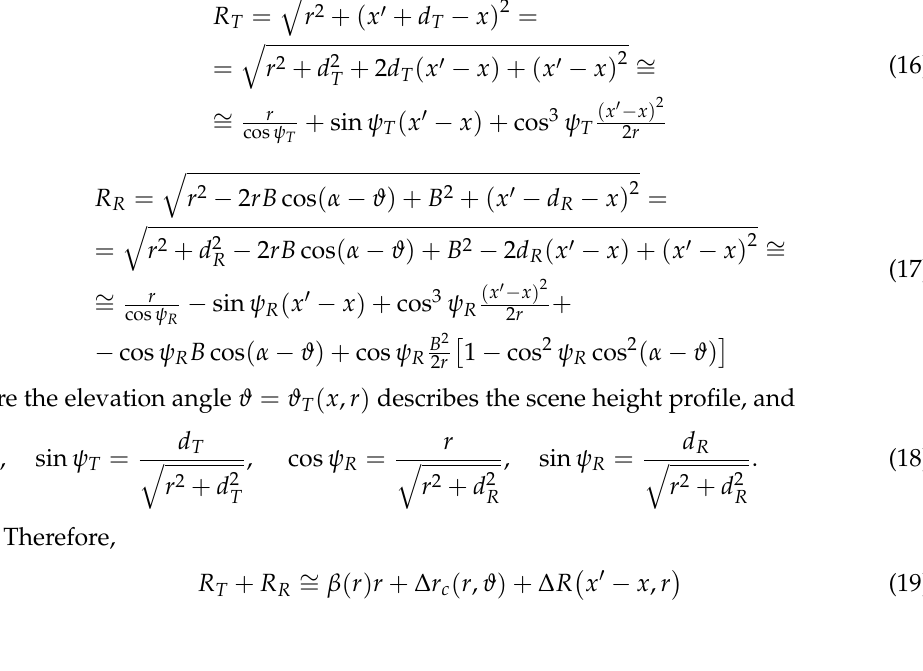
and (cid:1844) can be written as: (cid:3021) (cid:3019)